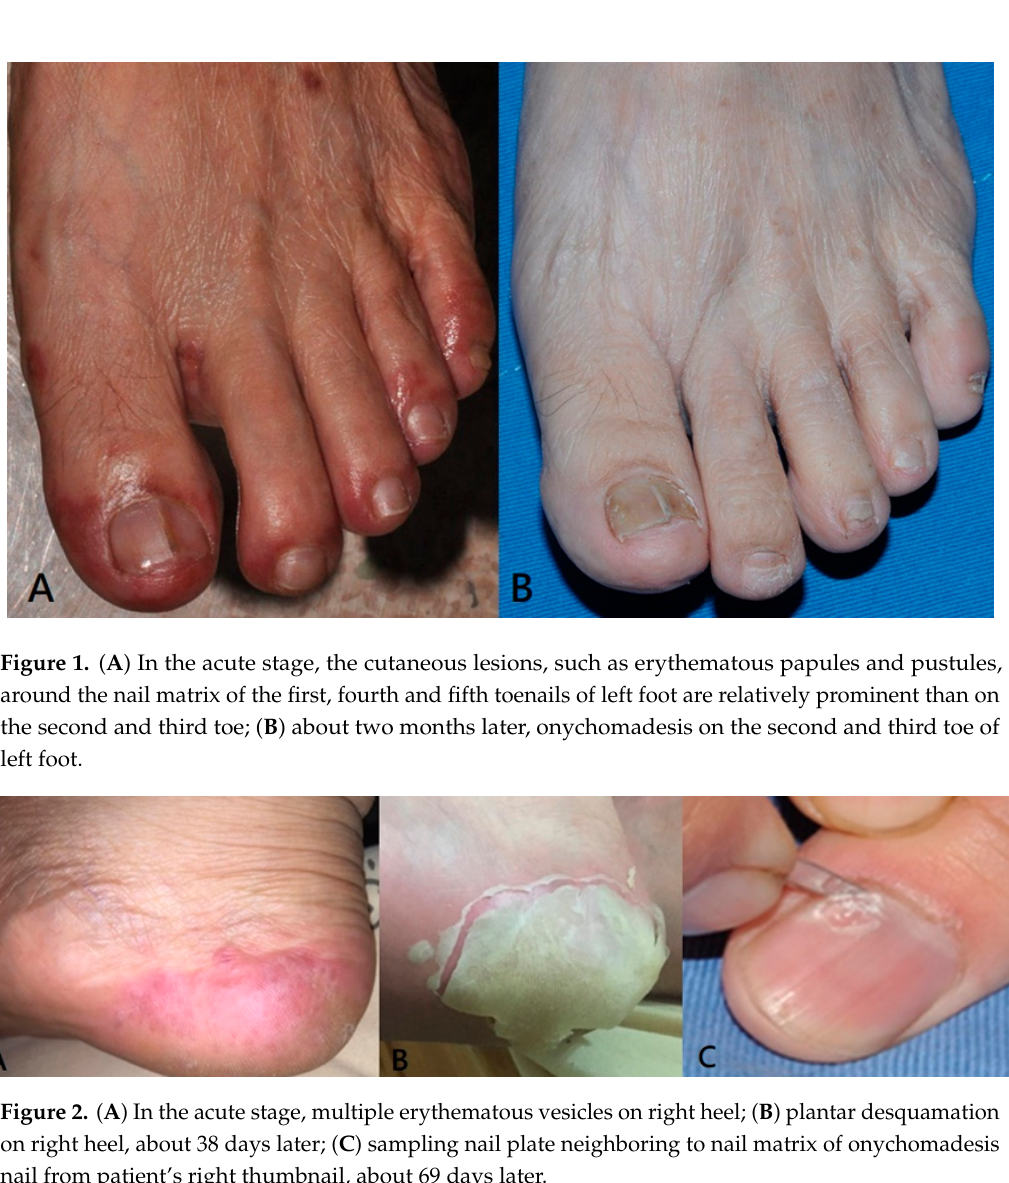
Figure 2. ( A ) In the acute stage, multiple erythematous vesicles on right heel; ( B ) plantar desquamation on right heel, about 38 days later; ( C ) sampling nail plate neighboring to nail matrix of onychomadesis nail from patient’s right thumbnail, about 69 days later.